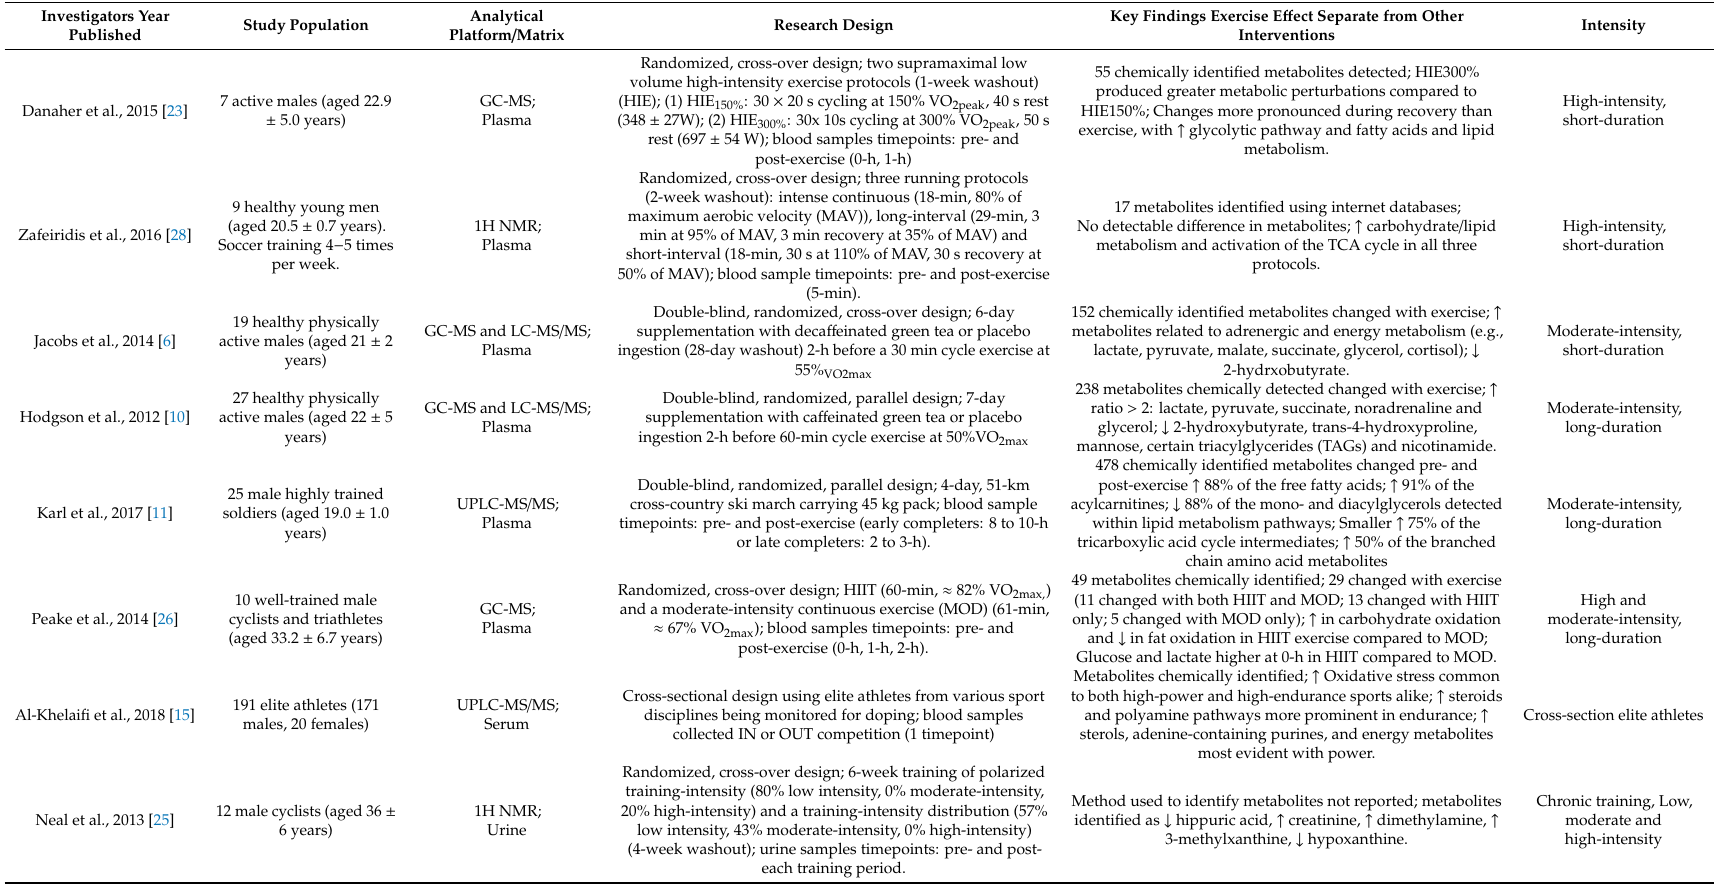
Table 3. Summaries of study characteristics and findings from nine [6,10,11,15,23,25–28] studies using other types of exercise